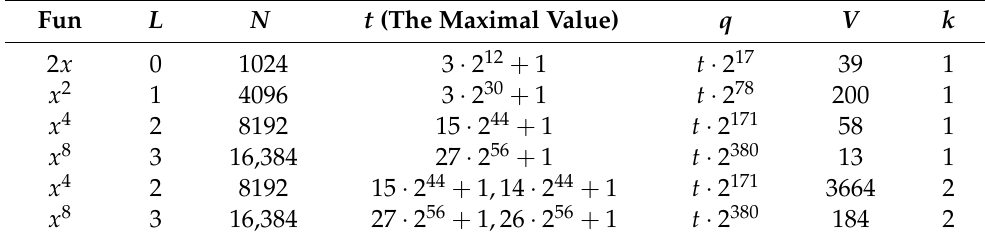
Table 1. Choice of parameters for evaluation of typical